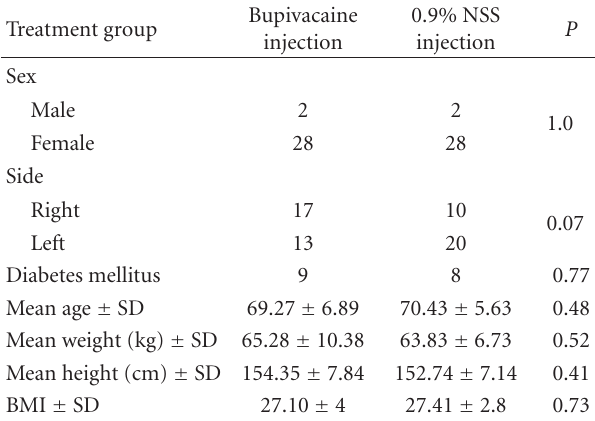
Table 1: Patient baseline demographic